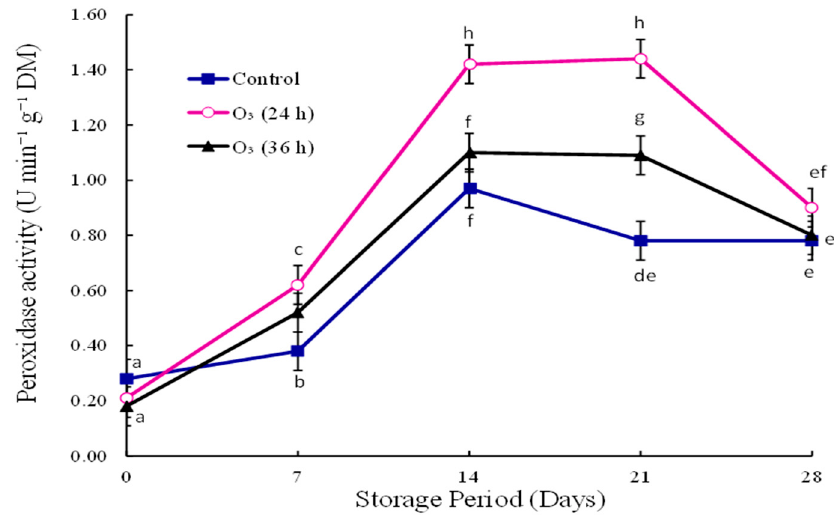
Figure 3. Effect of gaseous ozone (0.25 mg/L) on peroxidase activity in L. theobromae -inoculated mango fruit, stored at 10 °C for three weeks and ripened at ambient temperature for seven days ( p < 0.05; ± SE; n = 9). The letters a–h are used above or below the reported values. The means with the same letter are not significantly different (least significant difference = 0.14).